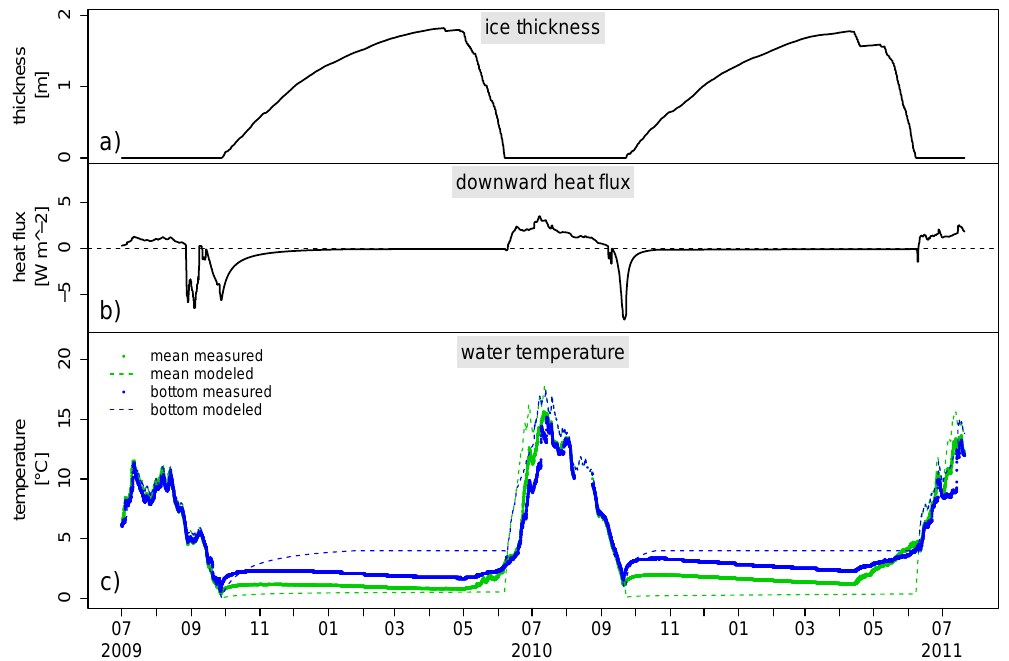
Figure 8. Modeled and measured hourly characteristics for Sa_Lake_1 from August 2009 to August 2011. (a) Modeled ice thickness; (b) modeled vertical heat flux at the water-sediment boundary: negative fluxes indicate fluxes from the sediment into the water column – a running median filter was used to remove spikes; (c) measured (continuous line) and modeled (dashed lines) lake-bottom and mean water